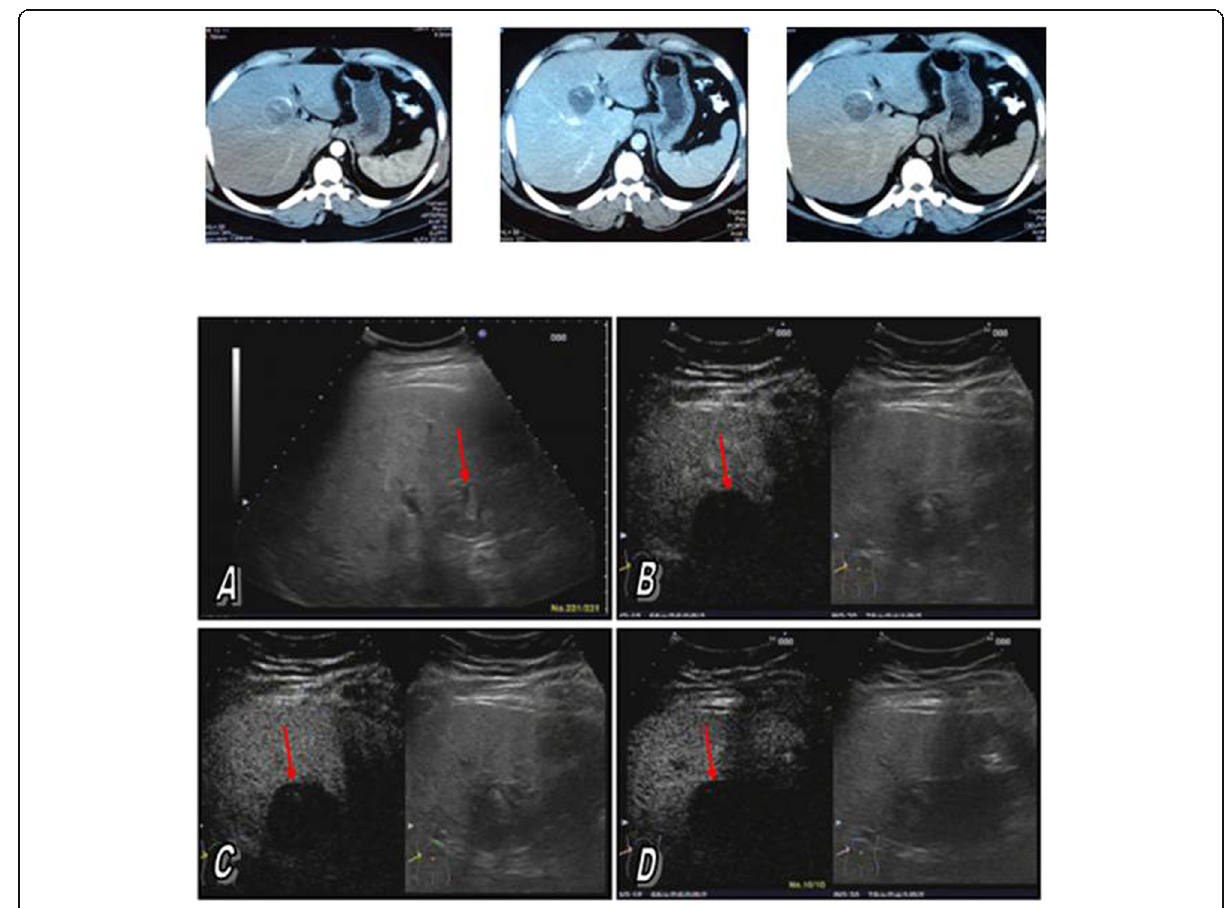
Fig. 6 A 36-year-old male, known case of hydatid disease. Triphasic CT study revealed left lobe segment IV cystic non-enhancing lesion with marginal calcification. a NEUS revealed average-sized liver showing left lobe segment IV heterogeneous cystic lesion measuring about 4 cm. b – d CEUS real-time examination during arterial phase, portal phase, and late phase showed persistent non-enhancement